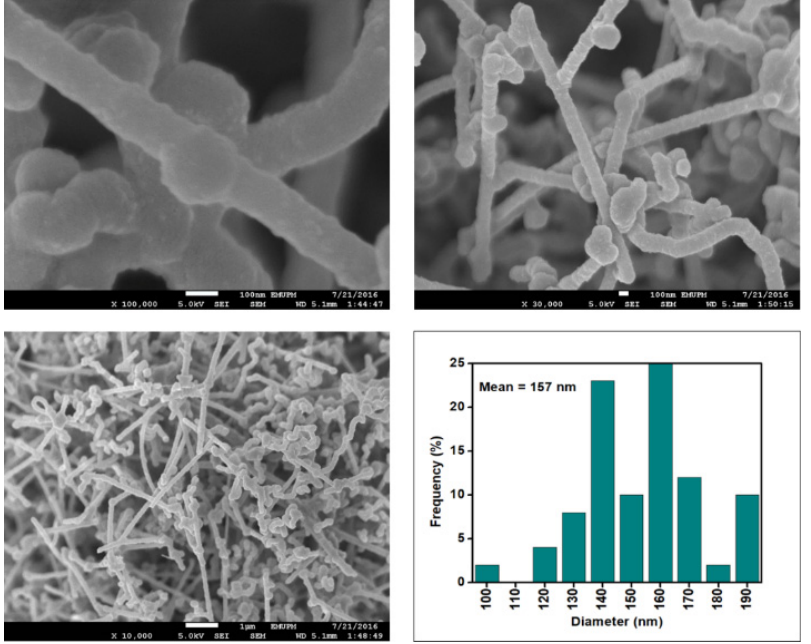
Figure 9. FESEM images of the CNF-MC at 100, 30 and 10 resolutions and their corresponding diameter distribution histogram (mean diameter = 157 nm).